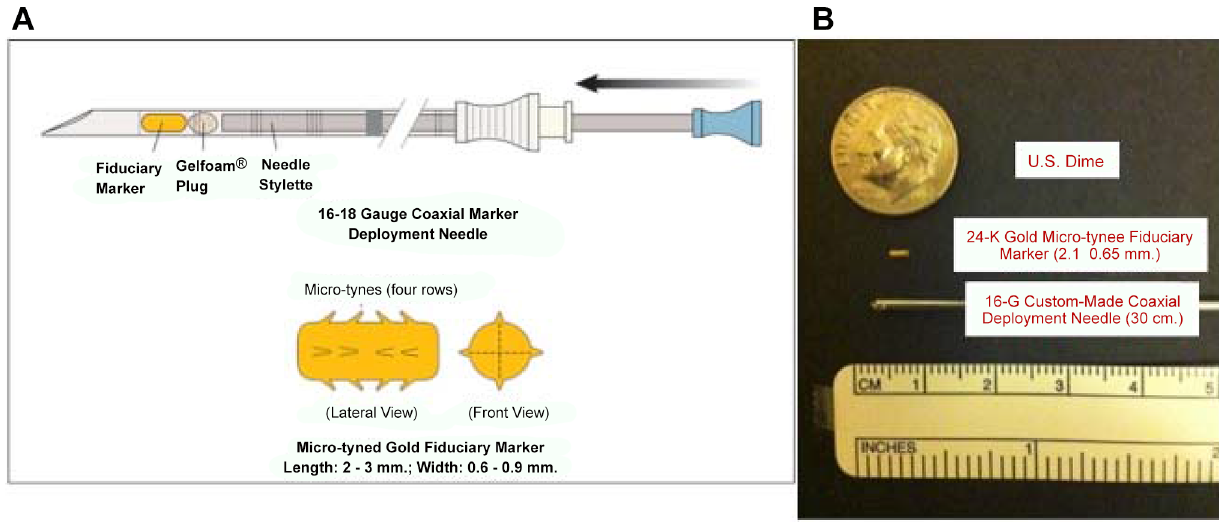
Figure 1. Gold bladder fiducial markers, Gelfoam TM plug, and custom-made coaxial deployment needles. A. Each 24-K gold micro- tined fiducial marker is manufactured with four length-wise rows of tines, whose points all face toward the center of the marker. The purpose of the micro-tines is to prevent the marker from migrating within the submucosal space. Each marker is deployed via a custom-made 30-cm. coaxial 18G needle into bladder submucosa. To prevent the marker from falling-out via the hole created by the placement needle, a small ‘‘plug’’ made of morcellated Gelfoam TM is deployed with (behind) the marker. B. 2.1 6 0.65 mm. gold fiducial markers are shown beside a custom-made 30-cm. coaxial 18G needle, and a U.S. dime.